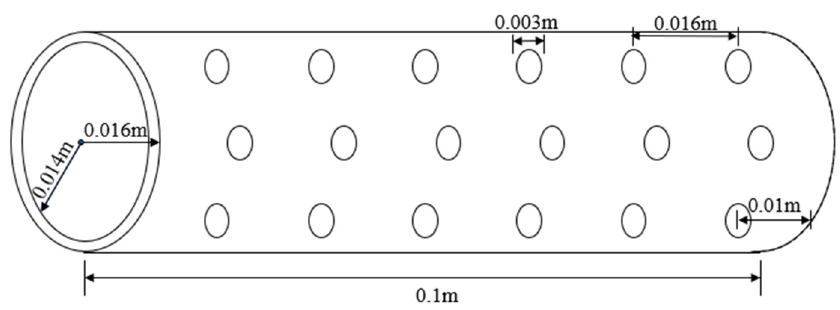
Figure 4. Schematic diagram of the supporting layer of the crossflow filtration module.